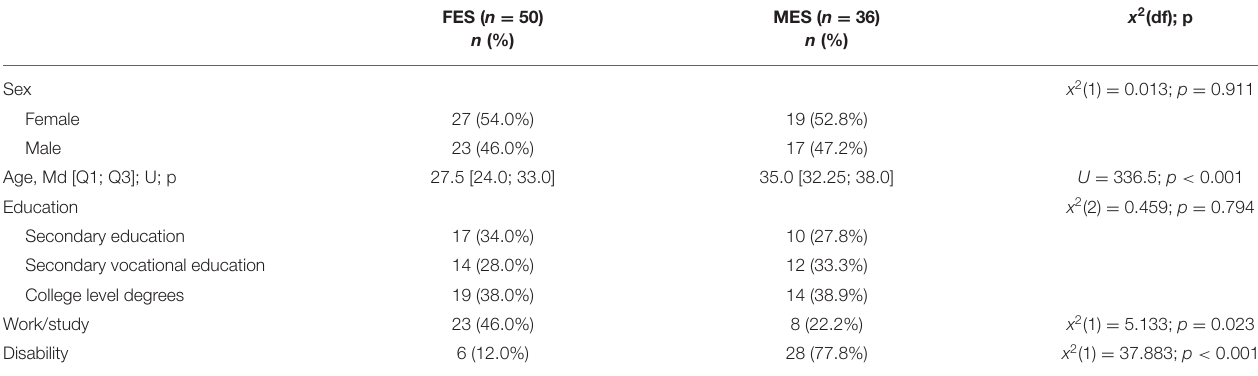
TABLE 1 | Socio-demographic characteristics.